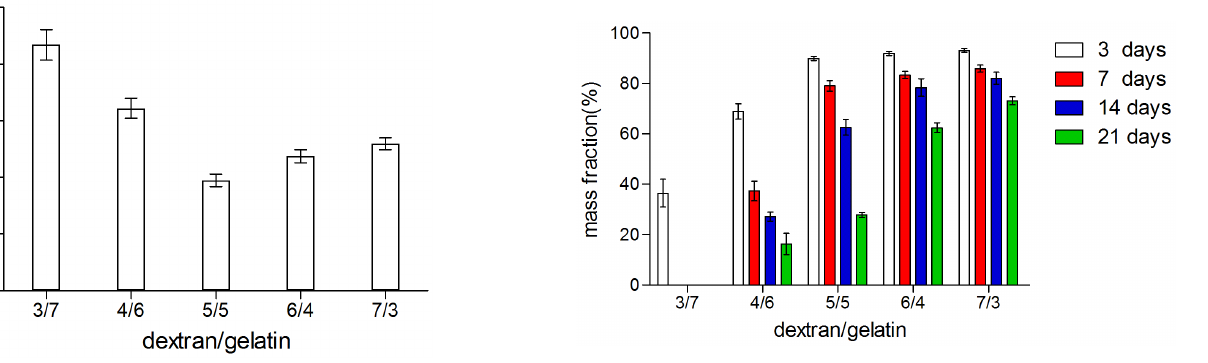
Figure 5. The swelling ratio of dextran/gelatin hydrogels with different volume ratio.